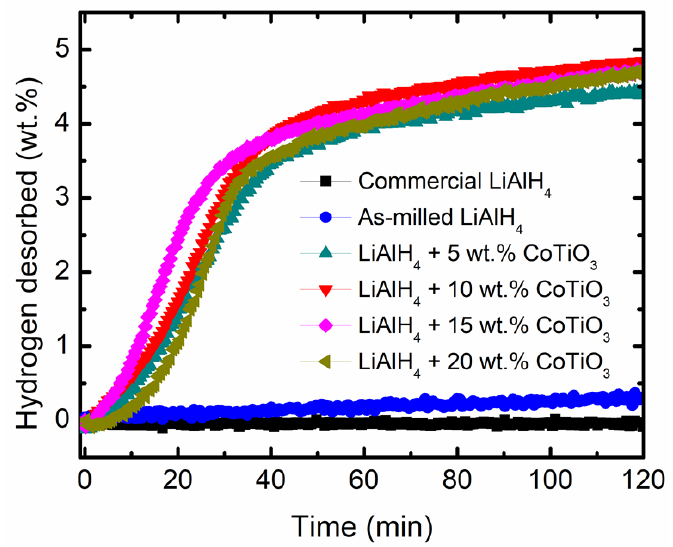
Figure 2. The desorption kinetic curve of commercial LiAlH 4 , as-milled LiAlH 4 and LiAlH 4 + x CoTiO 3 ( x = 5, 10, 15 and 20 wt.%).